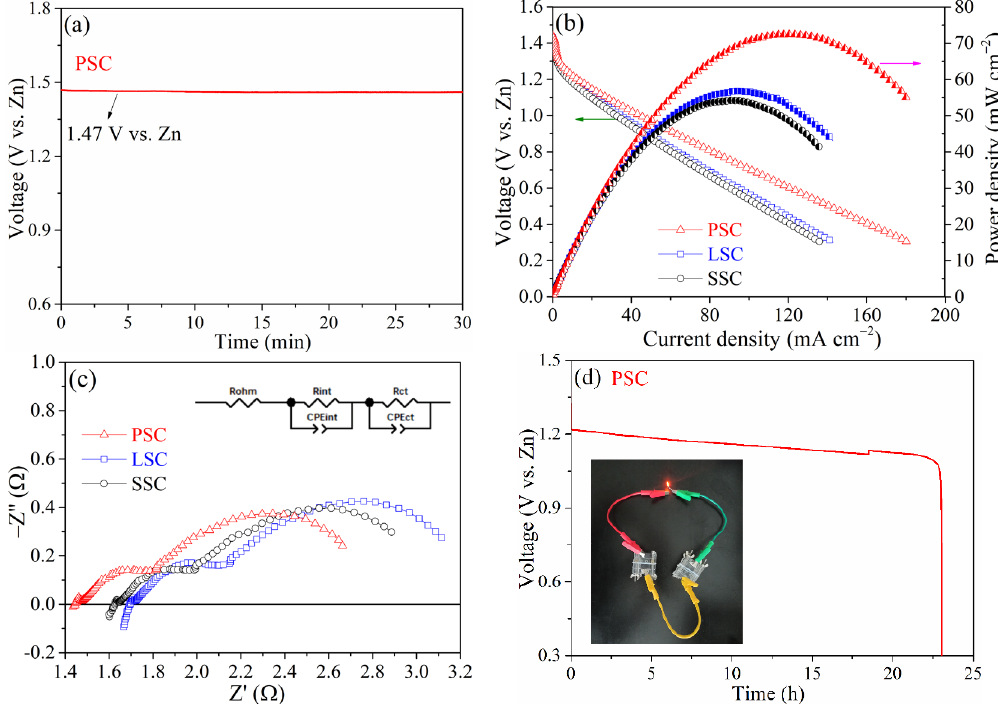
Figure 6. ( a ) The open circuit voltage curves of primary zinc–air batteries with PSC; ( b ) Discharge polarization curves and corresponding power density plots; ( c ) Nyquist plots obtained by the elec- trochemical impedance spectroscopy for primary zinc–air batteries at 1.2 V vs. Zn; ( d ) The long- term discharge performance (inset: a photograph of the working-LED lighted by two assembled primary zinc–air batteries in series connection).